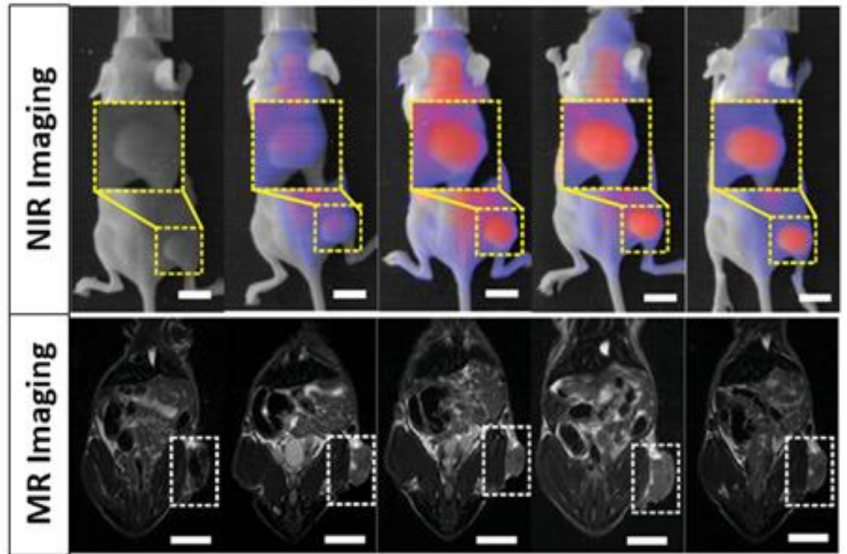
Figure 10. NIR and MRI mice images after administration of Janus nanoparticles. Adapted with permission from [96], Copyright 2021 Wiley-VCH GmbH.